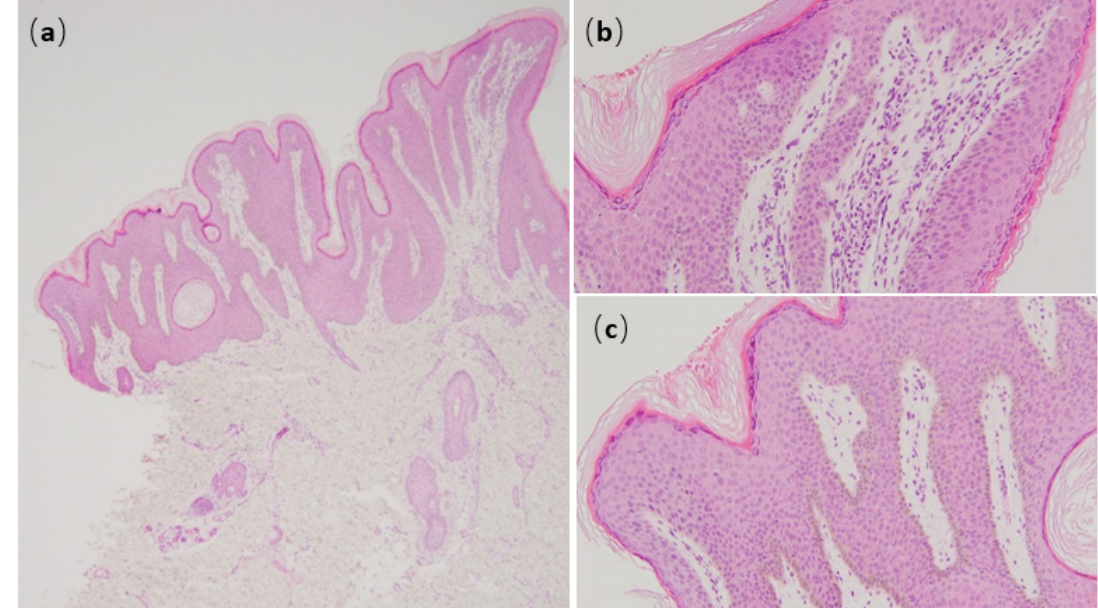
Figure 2. Histopathology of papillomatous plaques in the perianal region shows papillomatous epidermal hyperplasia associated with elongated rete ridges ( a ), perivascular infiltration of lymphocytes into the superficial dermis ( b ), and pigmentation of basal layer of epidermis ( c ).